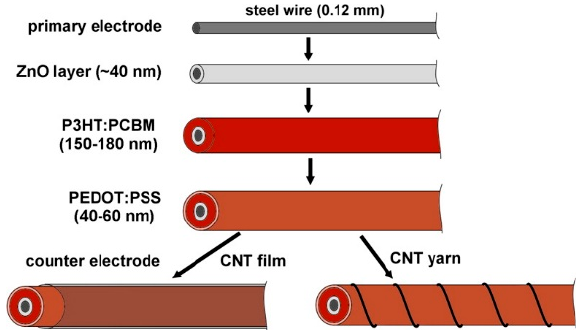
Figure 13. Diagram illustrating the fabrication process and structure of the fiber-shaped solar cells developed by Liu et al. Reprinted with permission from [142]. Copyright 2012 American Chemical Society.